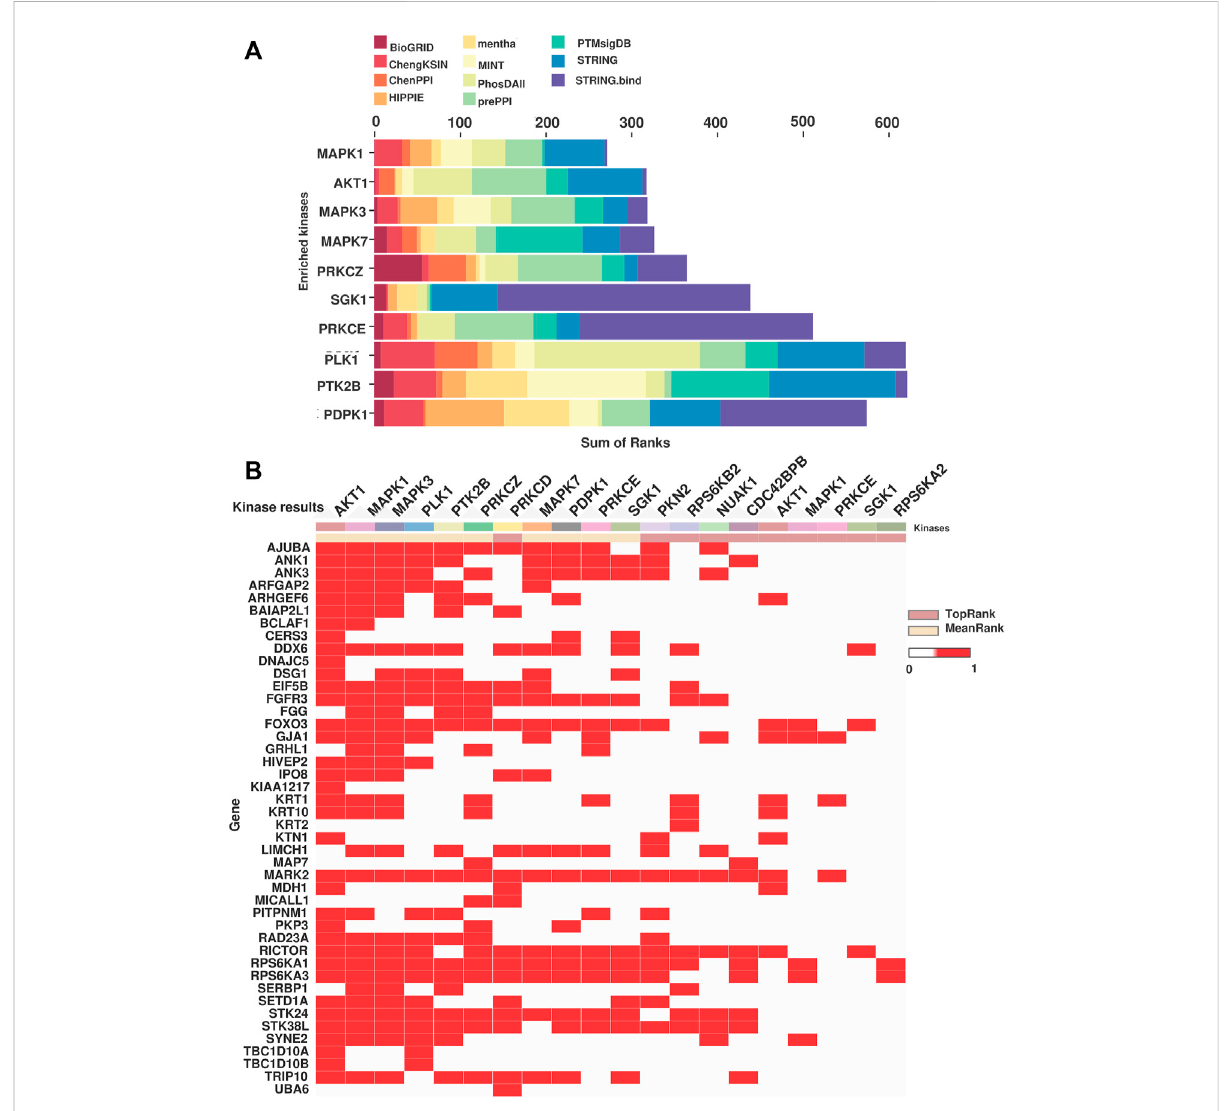
FIGURE 5 Kinase predicted to be enriched in the NACT resistant TSCC patients. (A) Bar chart representing the MeanRank visualization from KEA3 for the hyperphosphorylated proteins. Top ten kinases are plotted against the integrated ranking of the predicted kinases across different libraries based on MeanRank score. The bar is color coded by the library. (B) The clustergrammer visualization representing the top 10 ranked kinases based on the MeanRank and TopRank methods and putative substrates of the kinases. Each row are putative substrates from the input list and the column represent top 10 MeanRank and TopRank